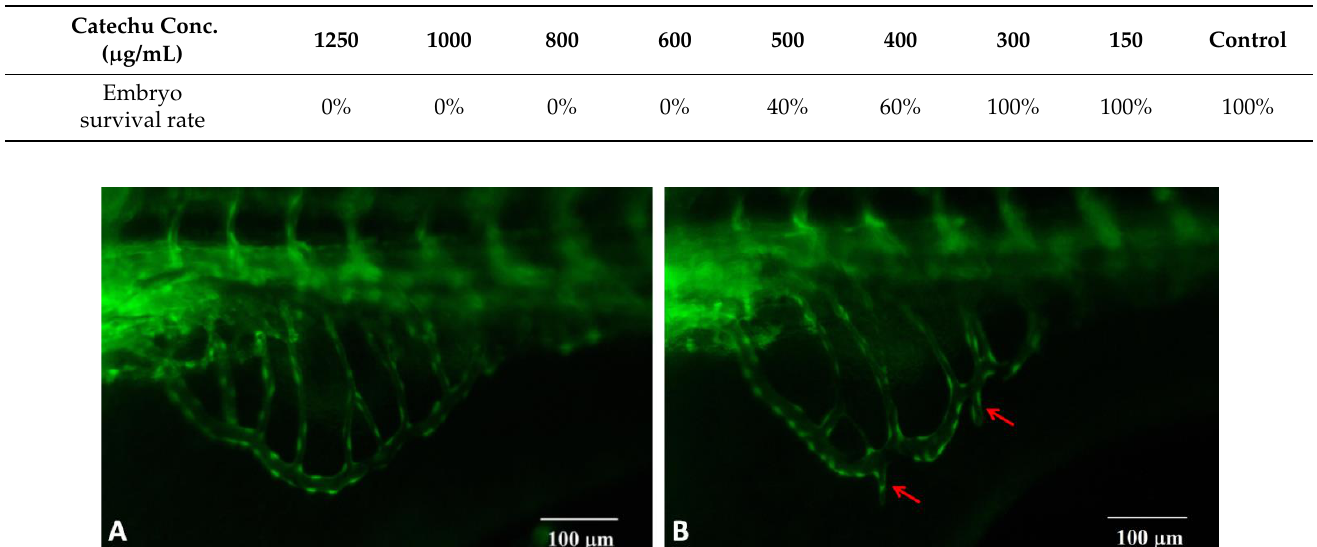
Table 1. The toxicity of crude catechu extracts on zebrafish embryos. Zebrafish embryos were treated with various concentrations of crude catechu extracts, from 1250 µ g/mL to 150 µ g/mL. About twenty embryos were used for each experiment.